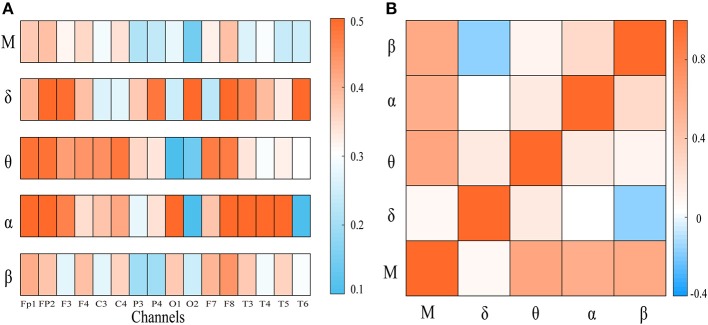
(A) The node clustering coefficient of the frequency-specific networks and cross-frequency networks for a representative patient. (B) The heat map represents the correlation of node clustering coefficient sequence between frequency-specific networks or between frequency-specific and cross-frequency networks. “M” denotes frequency-based multiplex network. Notice that the node clustering coefficient in multiplex network may be uncorrected or weakly correlated with that in frequency-specific networks.